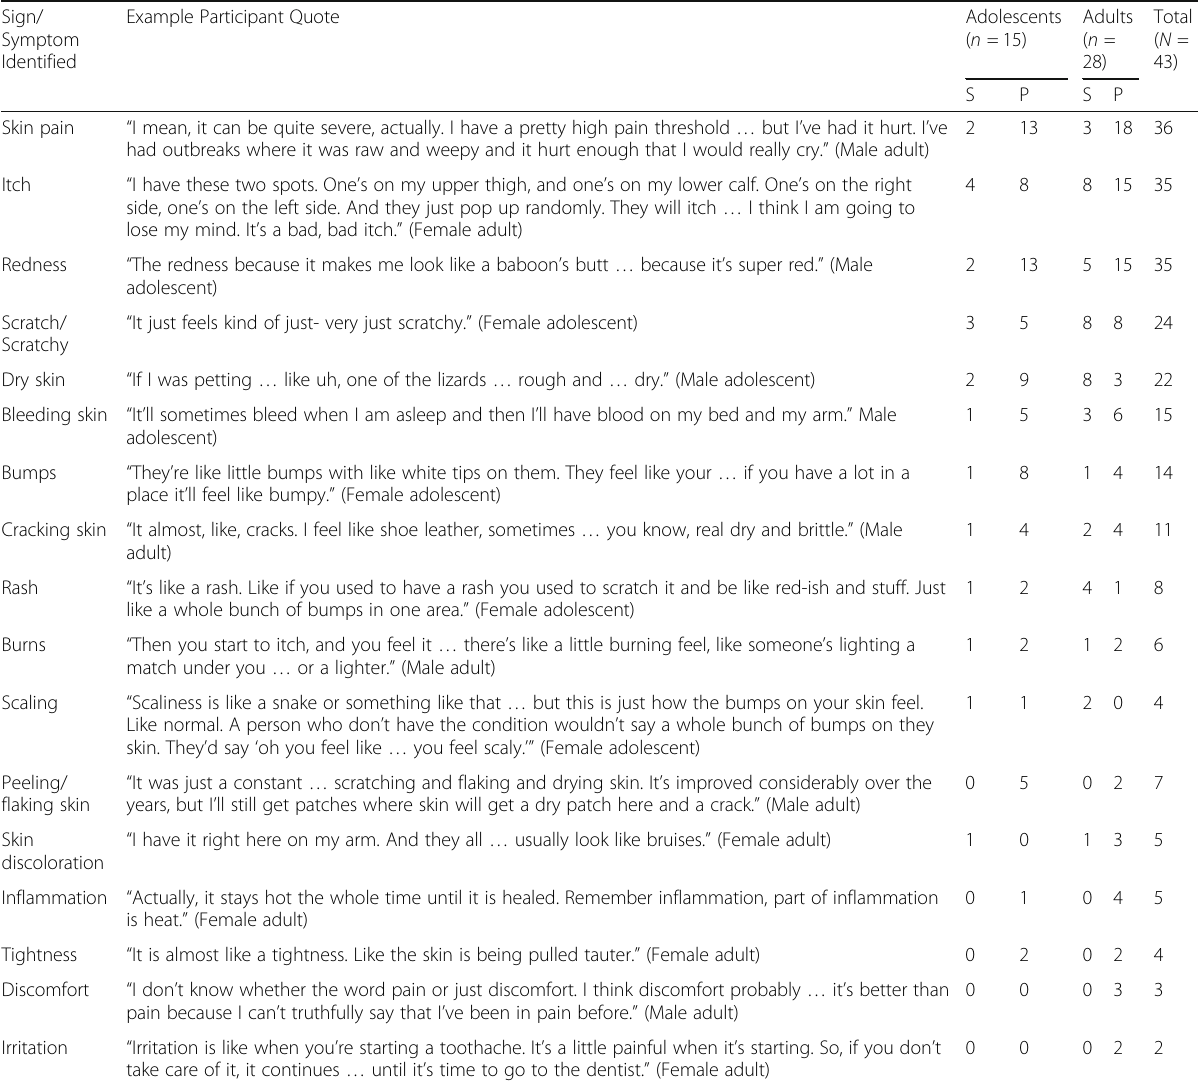
Table 2 Signs and Symptoms Identified by N = 43 Participants in the CE Interviews Sign/ Symptom